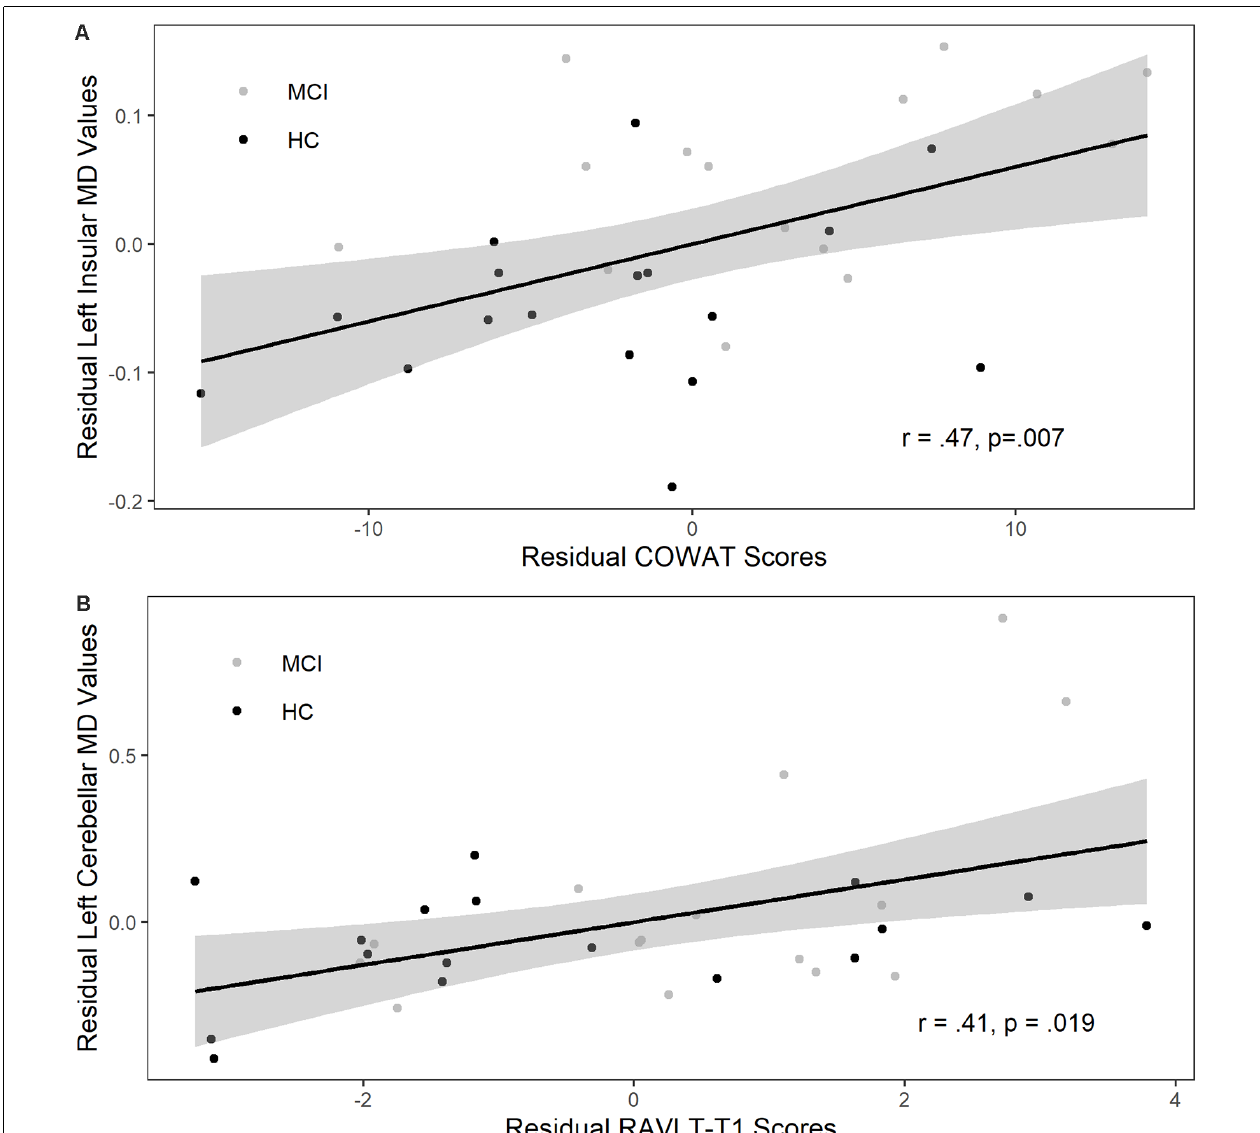
FIGURE 3 | Change in gray matter (GM) diffusivity was positively associated with improved verbal fluency and episodic memory performance. (A) Residualized change in verbal fluency (COWAT, Controlled Oral Word Association Test) scores were significantly related to residualized change in left insular MD values, controlling for age. (B) Residualized change in rey auditory verbal learning test (RAVLT) Trial 1 scores were significantly related to residualized change in left cerebellar MD values, controlling for age. The two groups are healthy controls (HC; black symbols) and those diagnosed with Mild Cognitive Impairment (MCI; gray symbols). Gray shaded region represents 95% confidence